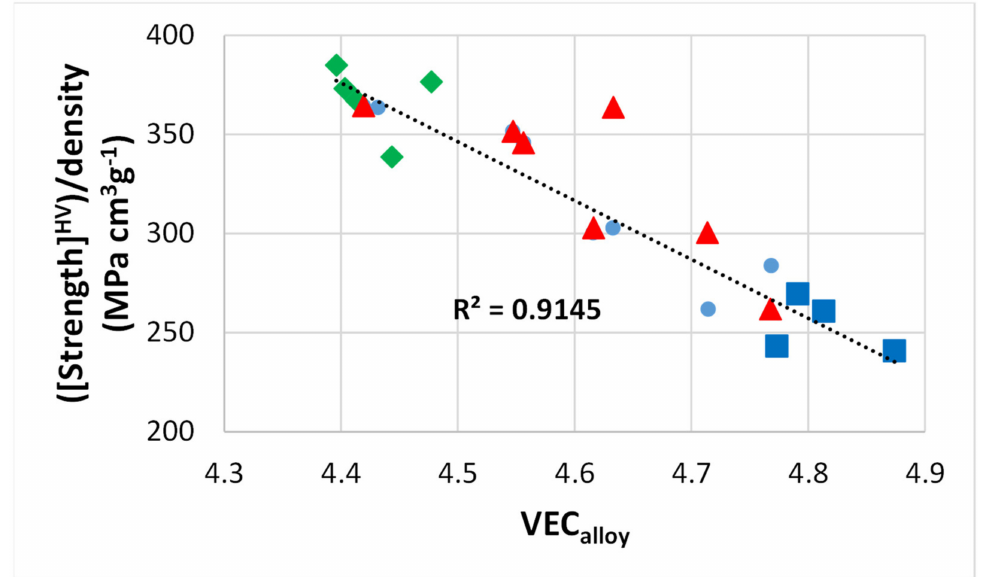
Figure 6. RT-specific strength (calculated by using hardness data and density of as cast alloys) versus VEC alloy . Green data for alloys with B [12,13,28], blue data for alloys without Ti [3], red data for Nb-24Ti-18Si KZ series alloys (see Appendix A for the nominal alloy compositions) [25,26].